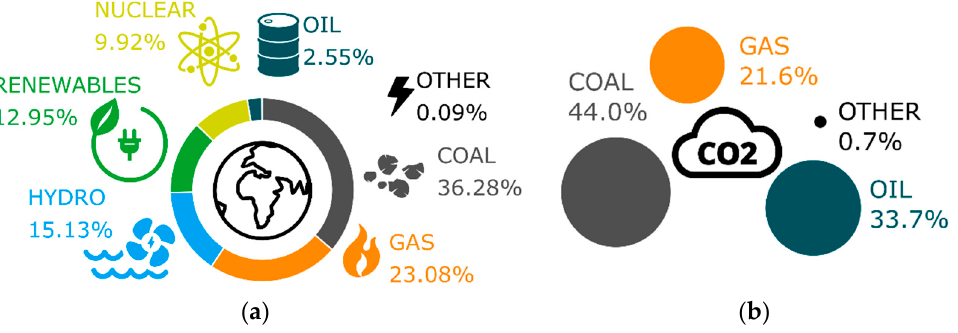
Figure 1. ( a ) Share of world electricity generation in 2021 (data source: [1]); ( b ) fuel share of CO 2 emissions from fuel combustion in 2019 (data source: [2]).